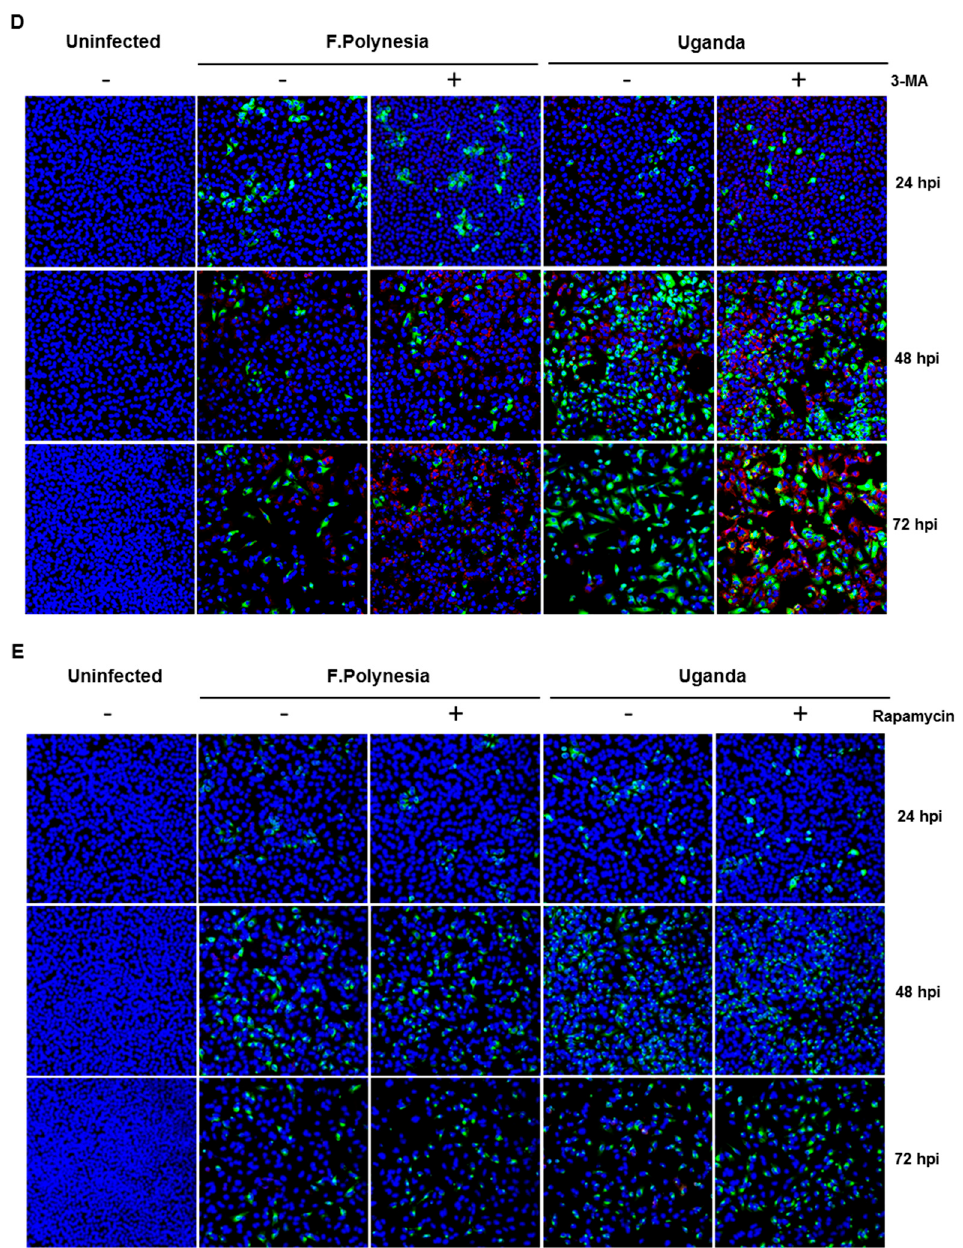
Figure 5. Autophagy modulation in ZIKV-infected cells. ( A – C ) A549 cells were infected with either the French Polynesia or the Uganda strain and treated with 10 nM bafilomycin A1 (pre- and post- infection treatment) during 24 ( A ), 48 ( B ), and 72 ( C ) hpi. Cell lysates of the indicated times were analyzed by Western blot with specific antibodies against the ZIKV NS1, p62, LC3, and β -Actin. The or the Uganda strain and treated with either 5 mM 3-MA ( D ) or 100 nM rapamycin ( E )